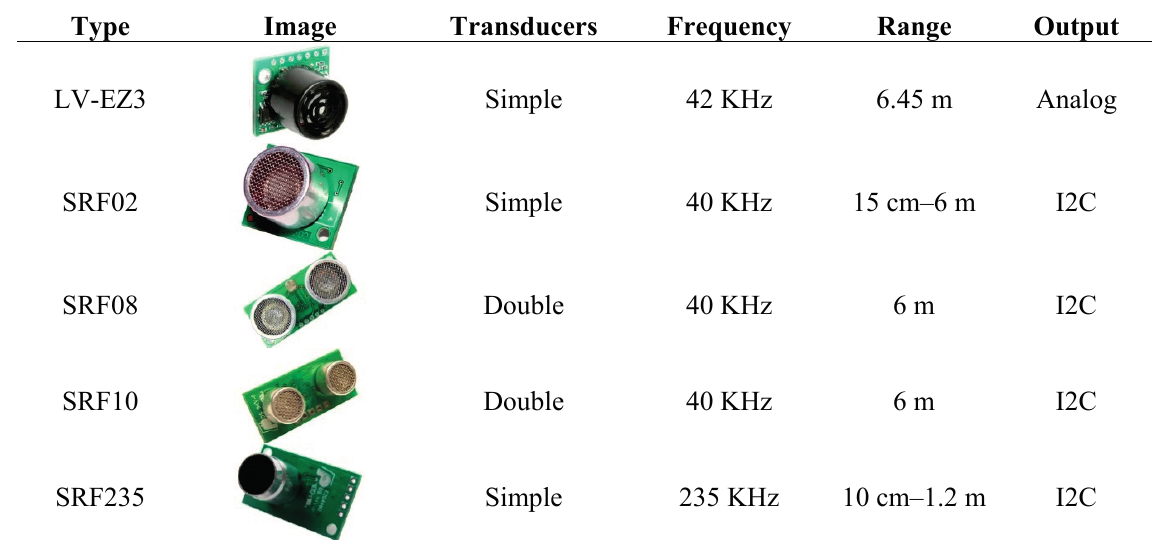
Table 1 . Ultrasonic sensors